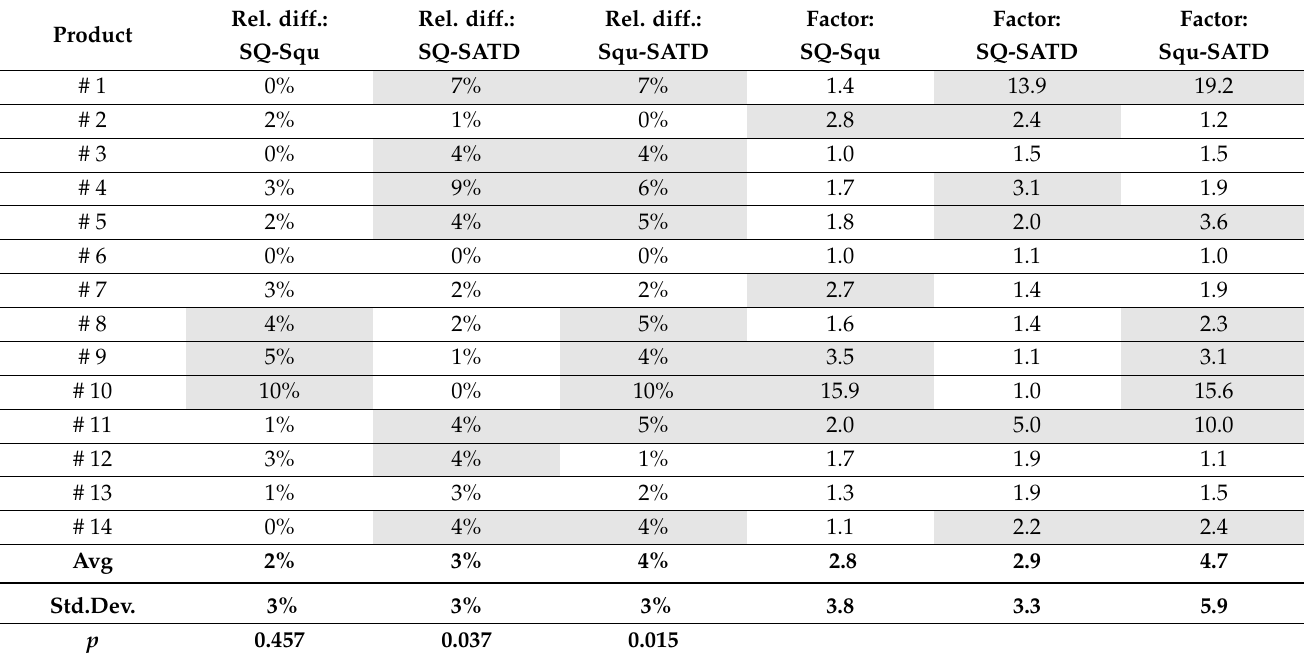
Table 4. Measured and admitted technical debt